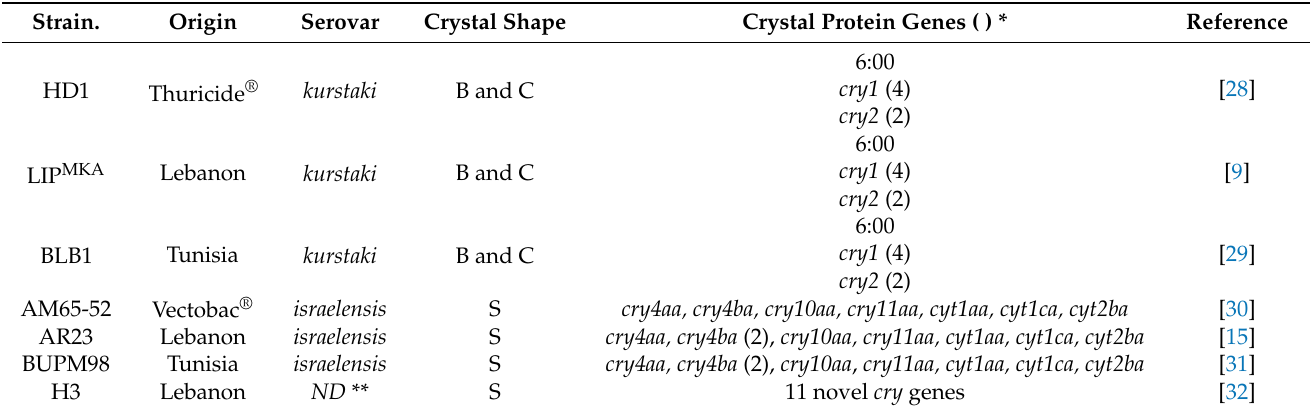
Table 1. Characteristics of the seven Bacillus thuringiensis strains used in this